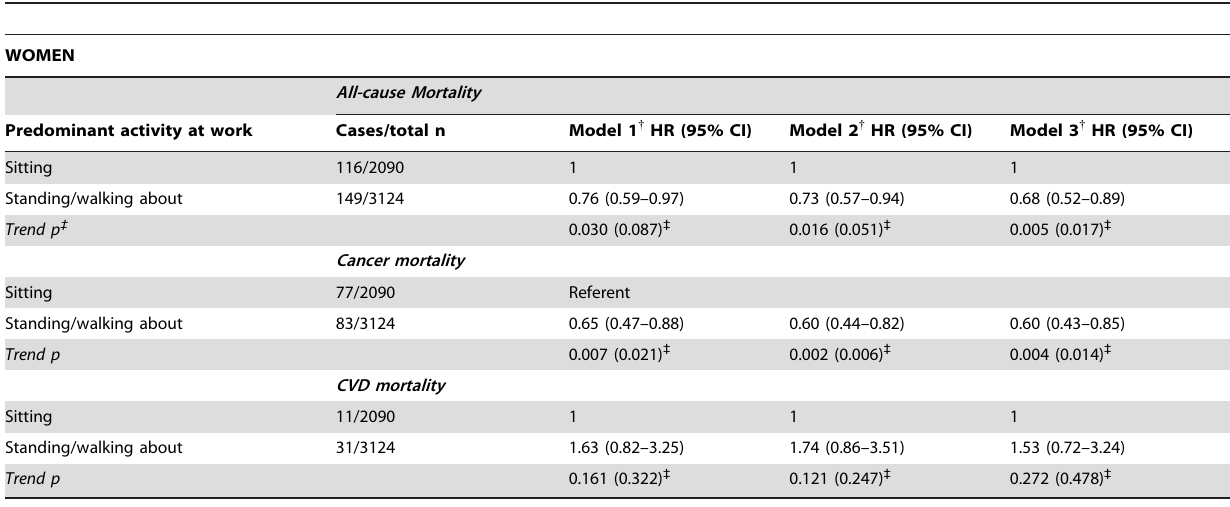
Table 2. Cox regression models for main activity while at work and all-cause/cancer/cardiovascular mortality in women aged $ 40 years who were in employment at baseline (n=5214).